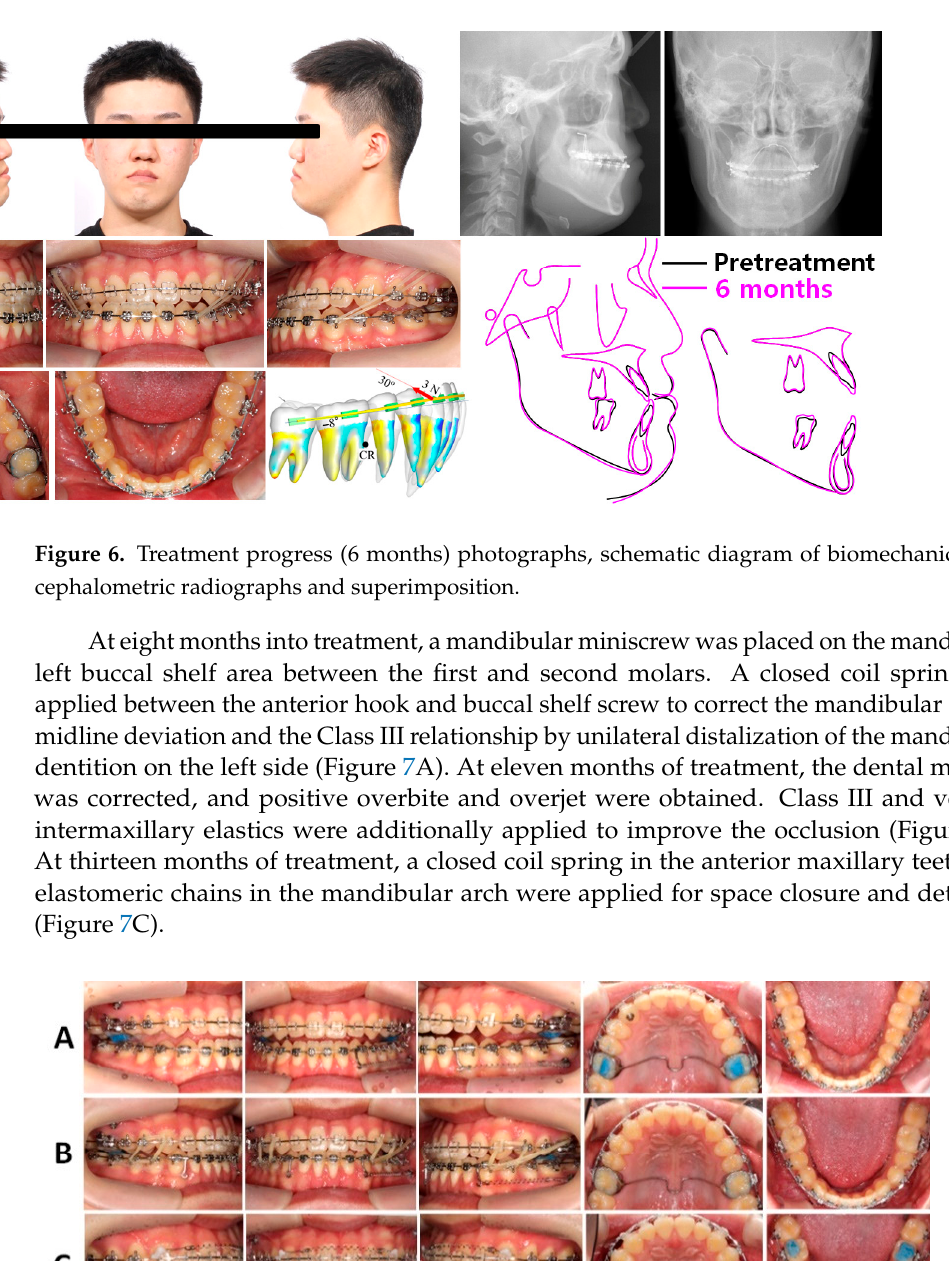
Figure 7. Treatment progress intraoral photographs (( A ) 8 months; ( B ) 11 months; ( C ) 13 months).